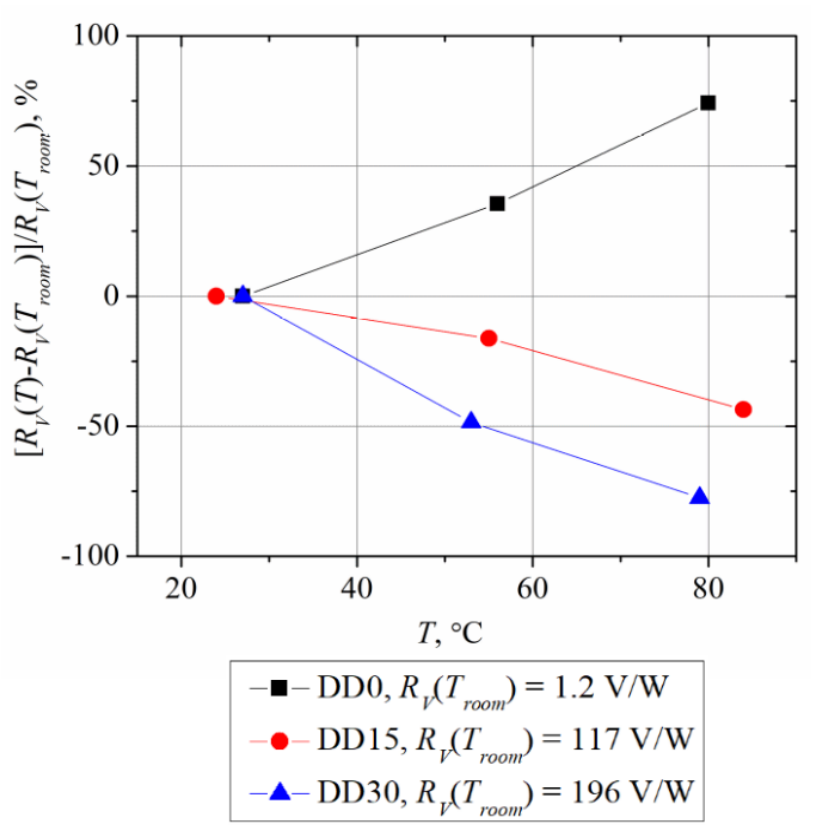
Figure 7. Temperature dependence of relative voltage responsivity change in the planar microwave diodes.